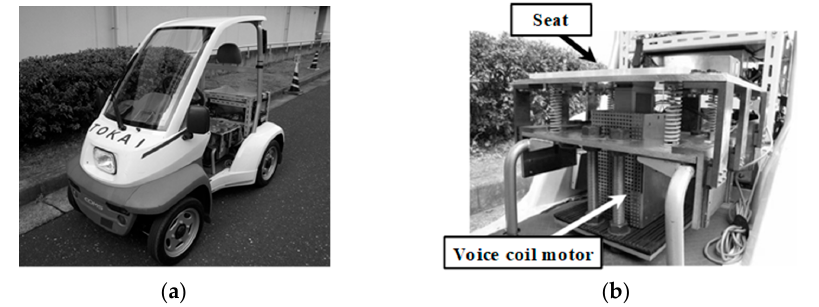
Figure 6. Ultra-compact vehicle and active seat suspension. ( a ) Ultra-compact vehicle; ( b ) Active seat suspension.